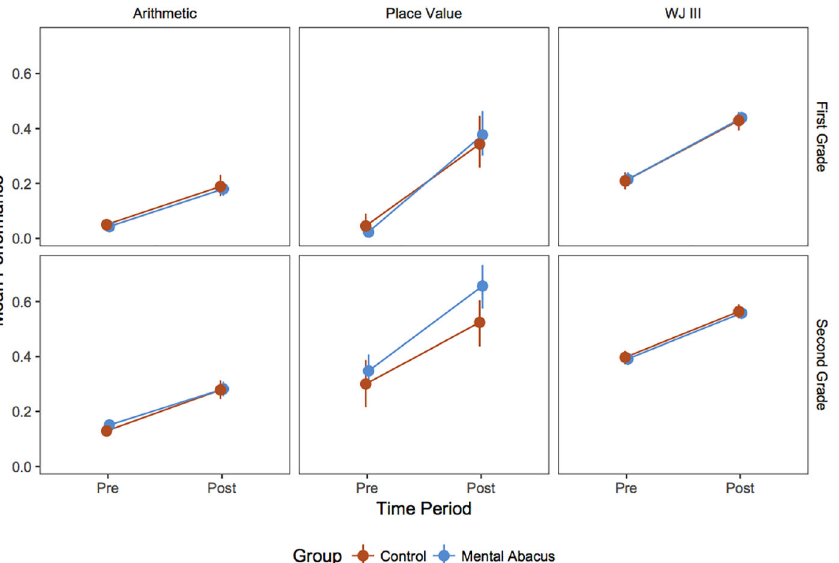
Figure 4. Performance on mathematics measures by time and grade. Error bars show 95% confidence intervals, computed by non-parametric bootstrap.